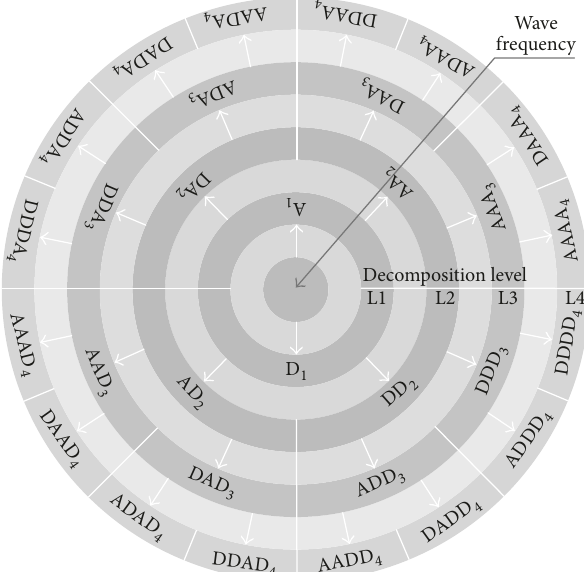
Figure 2: Decomposition structure in the frequency domain of a wave via the wavelet packet transform. The original wave at the basic level passes through two complementary filters (low-pass and high-pass) and emerges as two subwaves A 1 and D 1 . Subwave decomposition at the sublevel follows the same